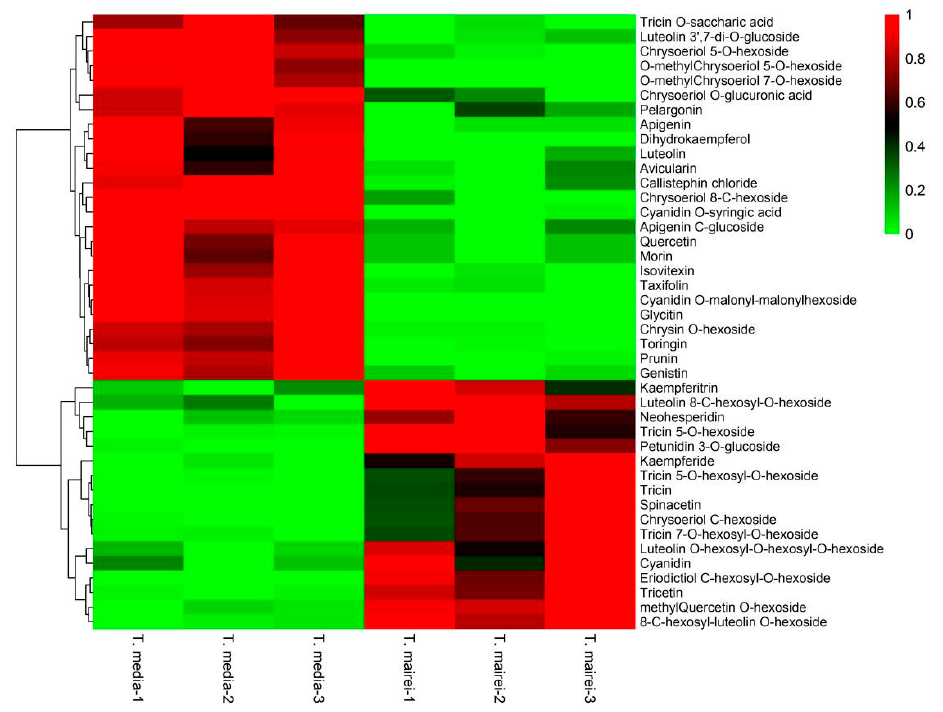
Figure 6. A heatmap of differential flavonoid metabolites between leaves of T. mairei and T. media ( n = 3). The content of each differential flavonoid metabolite is represented by a color bar. With the increase in the metabolite content, the color of the bar changed from green to red.